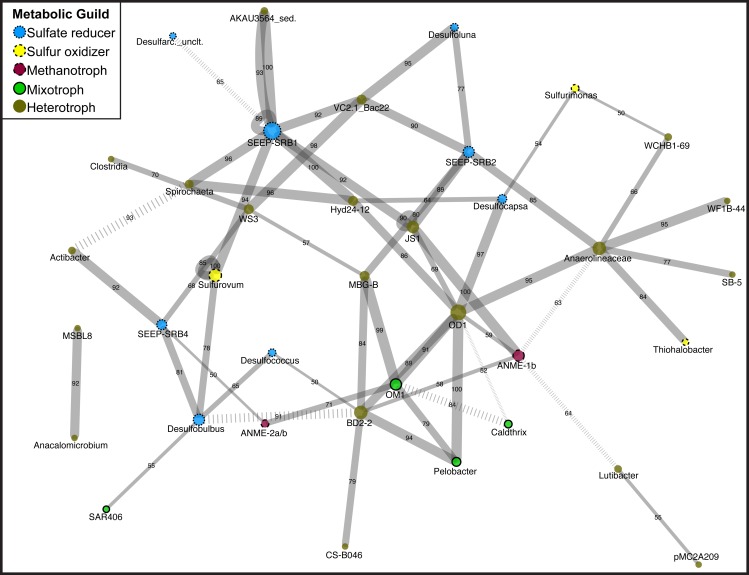
Network diagram of Magneto-FISH and bulk sediment samples.Co-occurrence analysis of the top 135 unique OTUs displayed in network form. Nodes represent the taxonomy of the OTUs in the network and edges are the connections between OTUs. Node size is scaled by number of connecting OTUs and colored by simplified, putative metabolic guild (sulfate reducer: blue, small dash; sulfur oxidizer: yellow, medium dash; archaeal methanotroph: magneta, large dash; mixotroph: green, no dash; heterotroph: brown, no outline). Edge thickness is scaled by number of occurrences of this association (from 50 to 100 times) and number of occurrences also included along edge. Negative associations are denoted by hashed lines. The combined network is displayed using Cytoscape, with the average correlation coefficient across all runs determining the distance between nodes and the number of occurrences in 100 network iterations determining edge width.